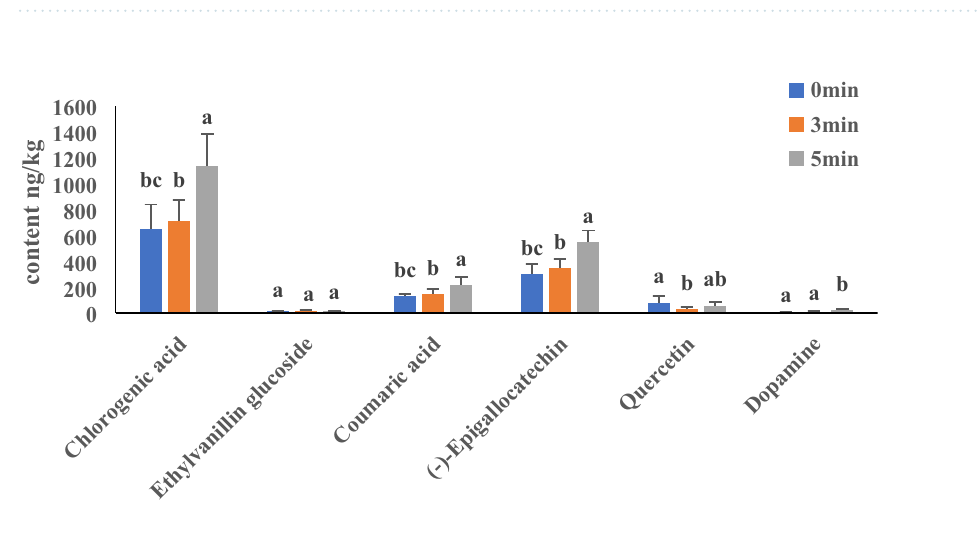
Figure 3. Heatmap showing the differences in expression levels of metabolites.